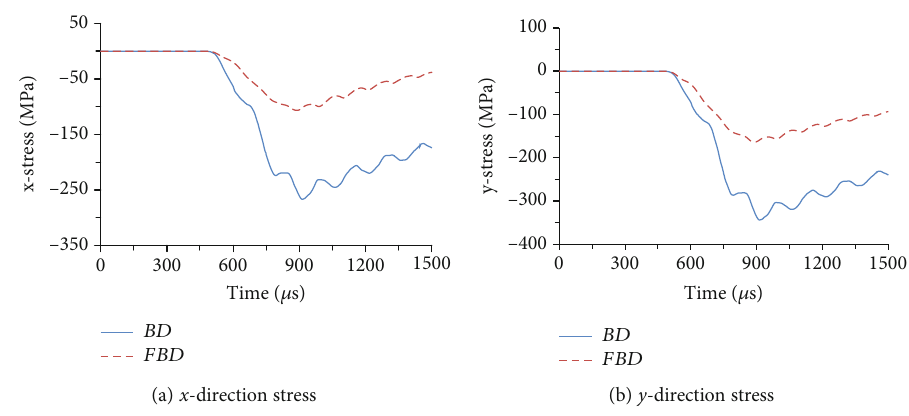
Figure 19: Nonaxial stresses at the center unit of the end of the two specimens.